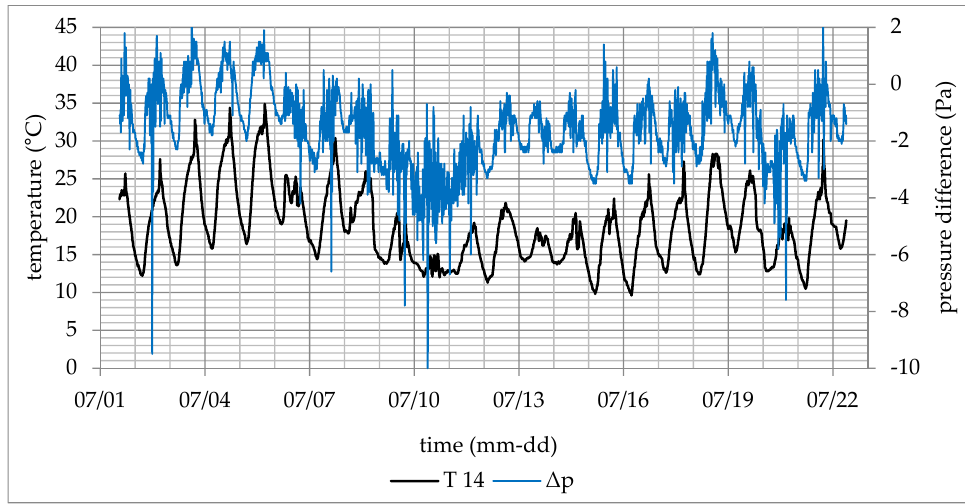
Figure 6. External air temperature and pressure difference between the lecture room and environment.